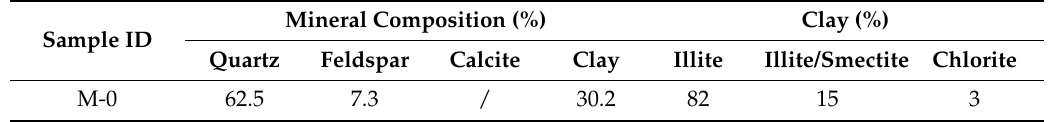
Table 2. Mineral compositions of the initial shale sample.